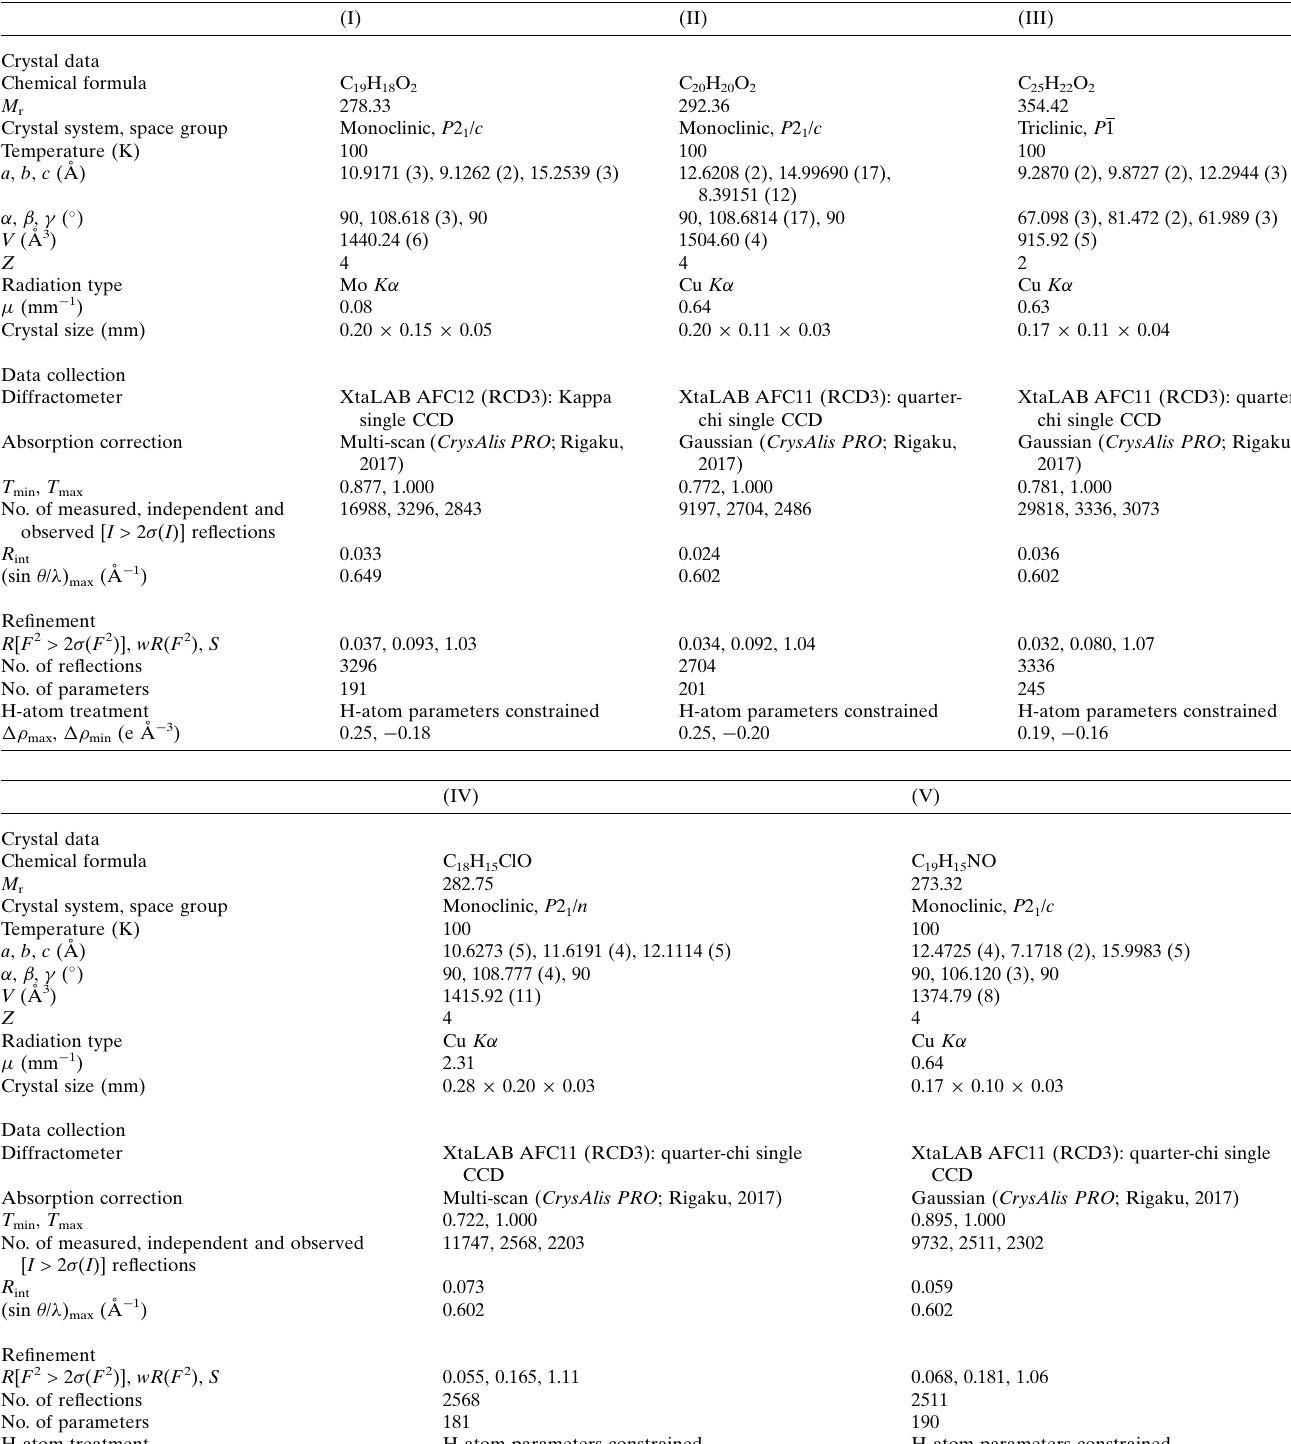
Table 8 Experimental